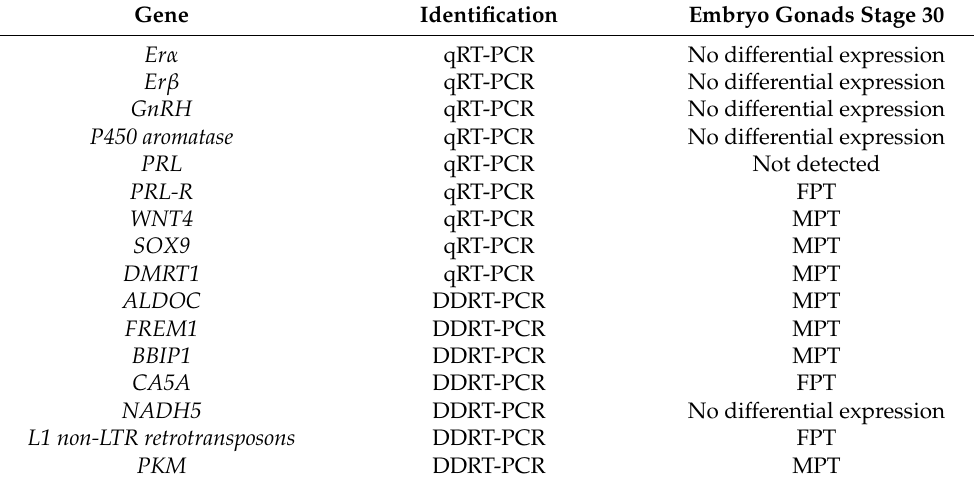
Table 4. Summary of the differentially expressed genes in E. macularius embryo at stage 30, listed according to the two different methodologies used. MPT stands for genes more expressed at a male- producing temperature and FPT stands for genes more expressed at a female-producing tempera- ture.